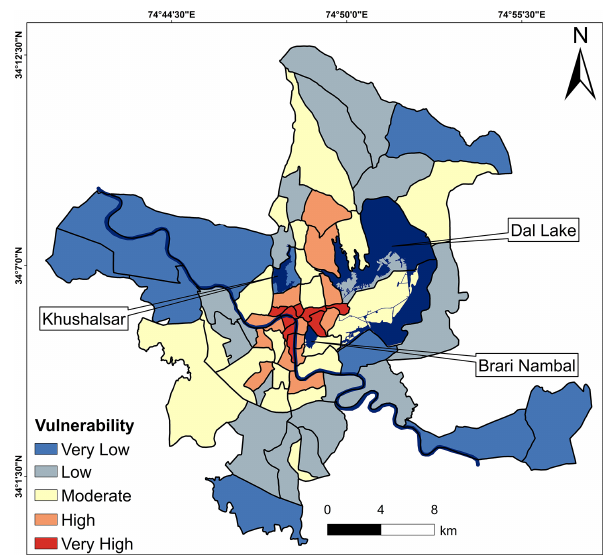
Figure 10. Structural vulnerability of